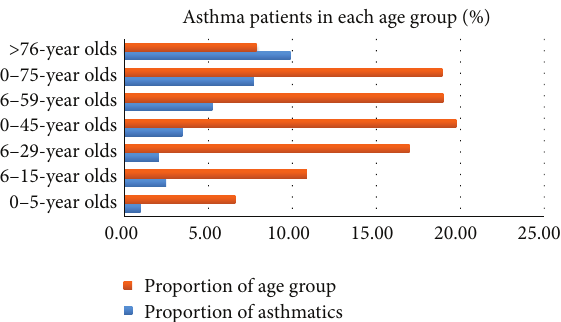
Figure 1: Proportion of asthmatics in different age groups and proportion of the age group of total population in